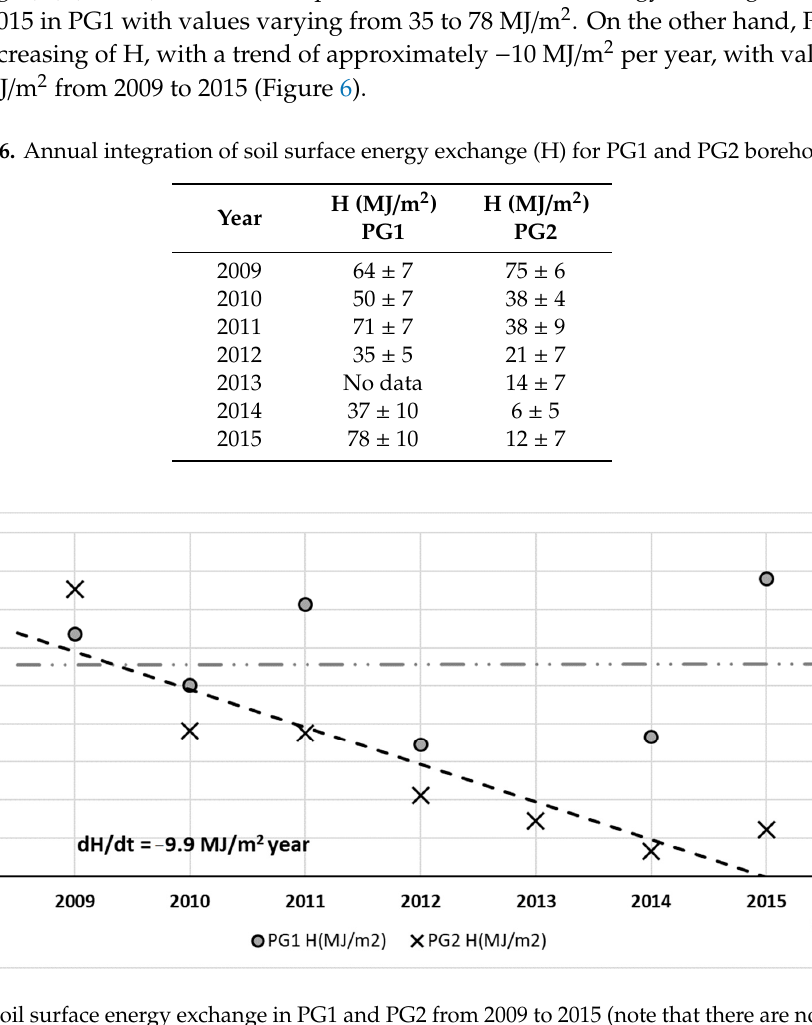
Table 5. Zero thermal annual amplitude depth (ZAA) at boreholes PG1 and PG2.